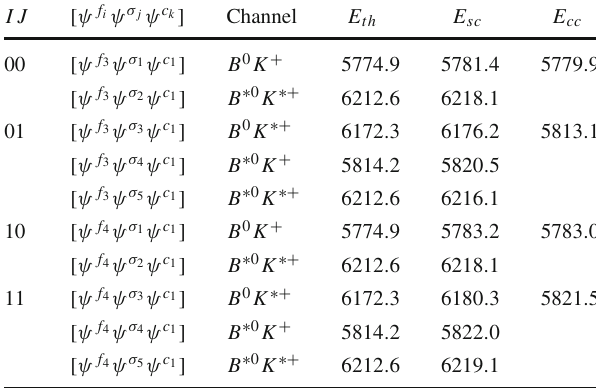
Table 5 The energies (in MeV) of the meson-meson structure for tetraquarks ud ¯ s ¯